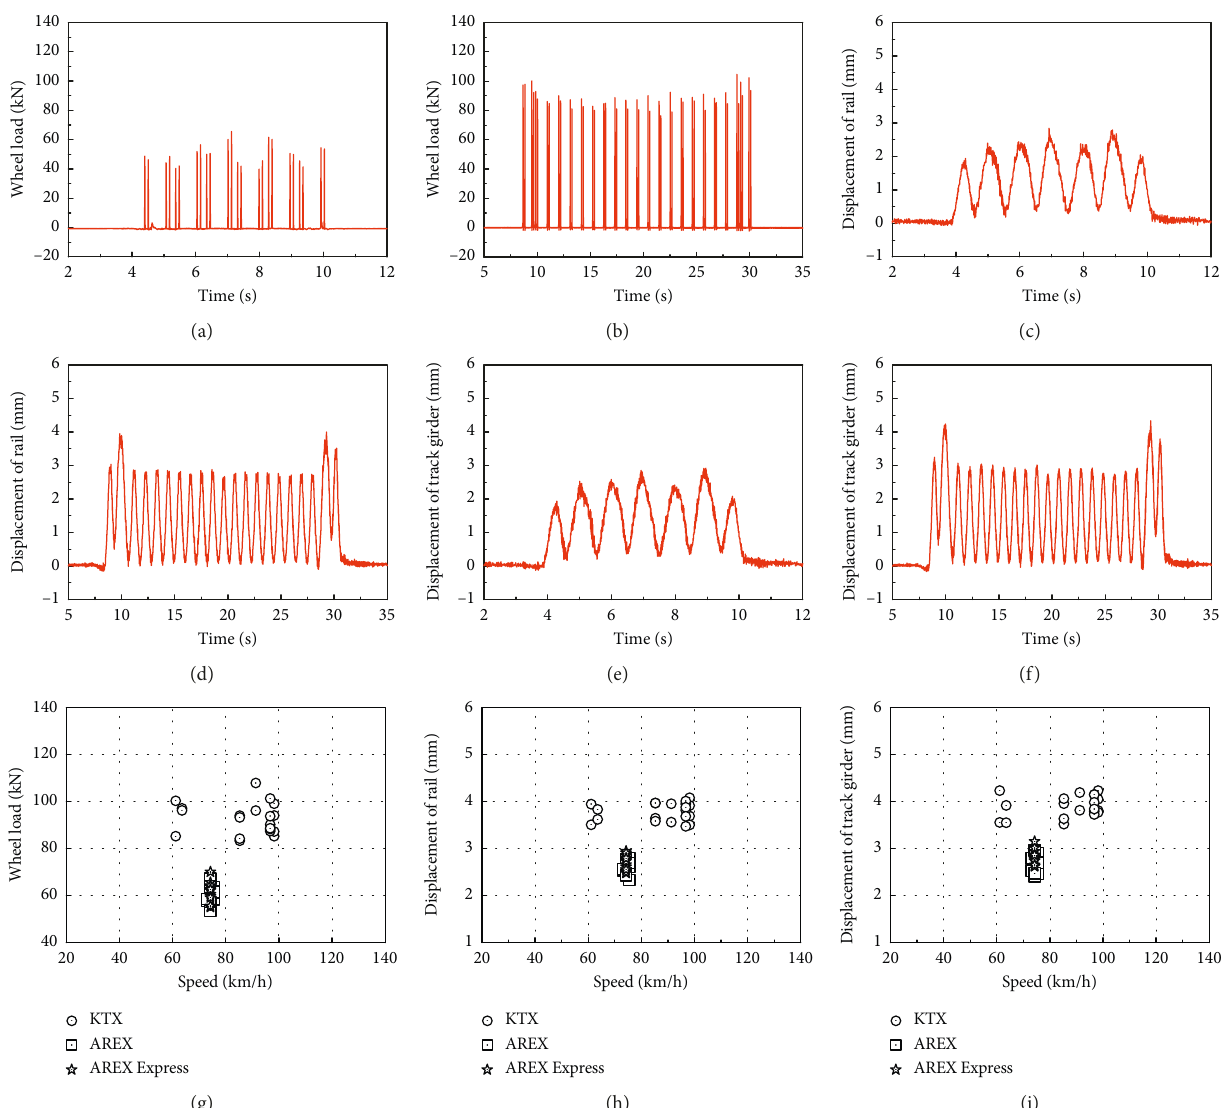
Figure 4: Examples of measured data: (a) wheel load (AREX); (b) wheel load (KTX); (c) rail displacement (AREX); (d) rail displacement (KTX); (e) track girder displacement (AREX); (f) track girder displacement (KTX). Measurement results of a direct fixation track on a bridge according to train speeds: (g) wheel load; (h) rail displacement; (i) track girder